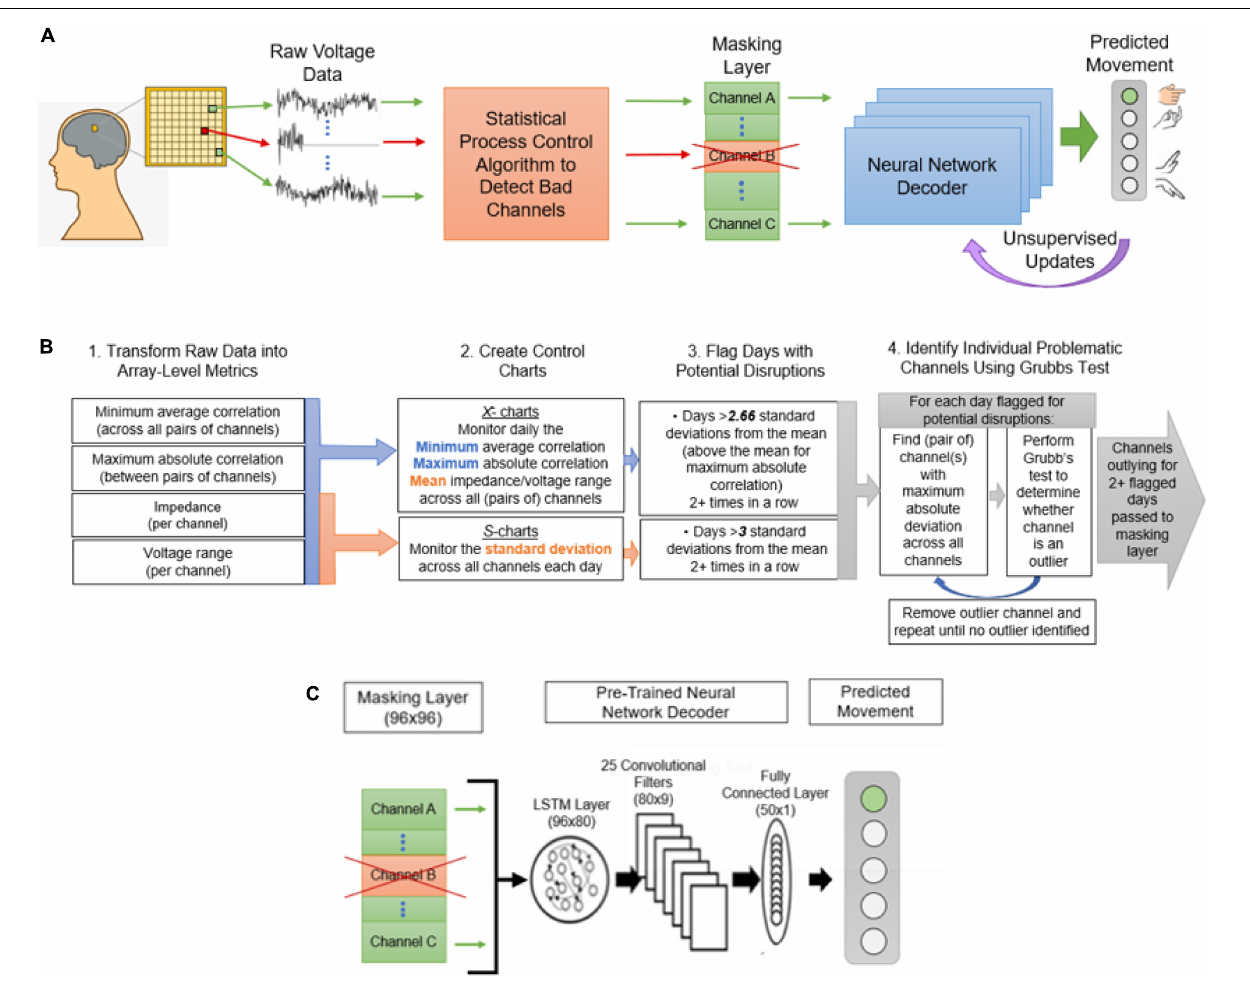
FIGURE 1 | The proposed decoding framework for handling channel disruptions. (A) Raw voltage data and impedance measurements recorded from the implanted electrode array will be delivered to the statistical process control algorithm, where channels with disruptions will be identified. The discovery of disruptions will cause the input from the affected channels to be masked, or zeroed, before being sent to the decoder. This will also trigger an unsupervised update to readjust the weights to the missing input. (B) The statistical process control algorithm to detect disrupted channels is described. The four steps in this process are (1) transforming raw data into four array-level metrics useful for signal monitoring, (2) creating control charts for each of the metrics, (3) using the control charts to flag sessions with potential disruptions, and (4) performing Grubb’s test to determine outlying channels on the flagged sessions. (C) The decoder framework, including a masking layer, an LSTM with 80 hidden units, 25 convolutional filters, a fully connected layer, and finally a 5-unit layer corresponding to the output.